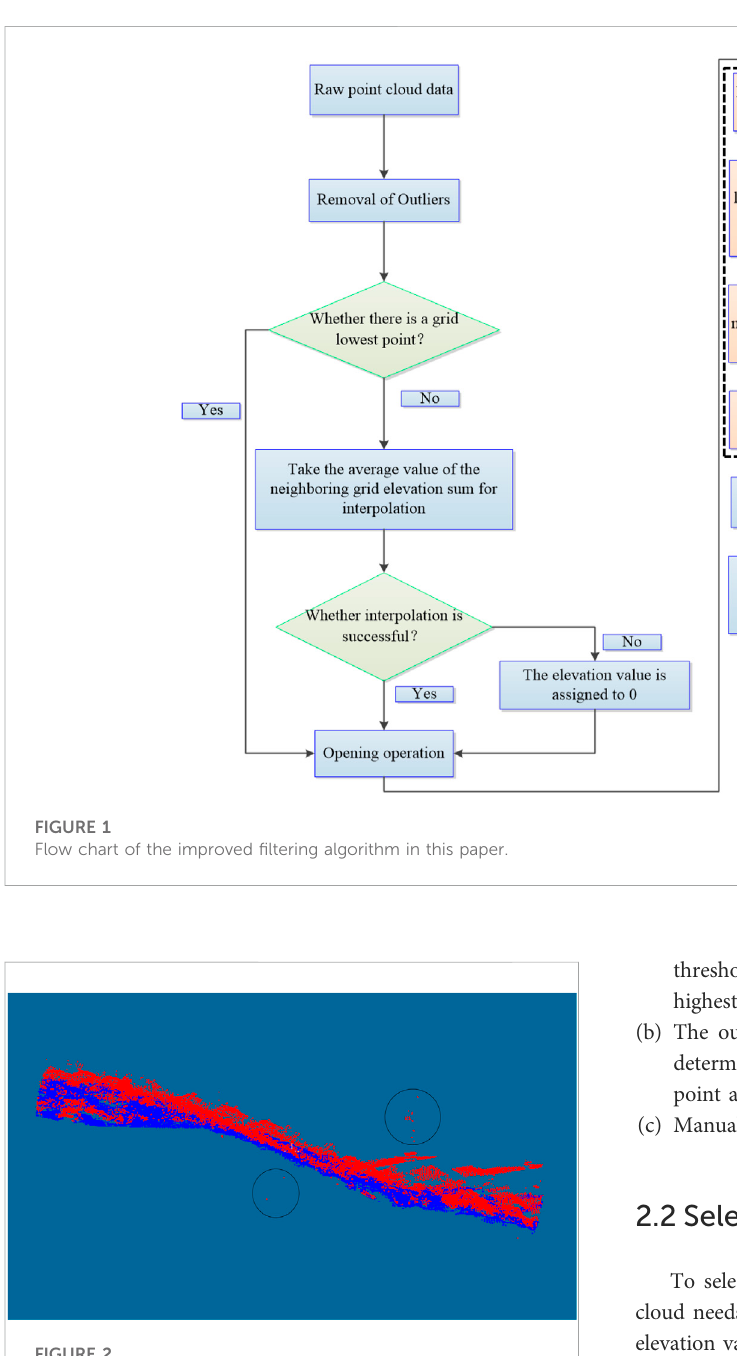
FIGURE 2 Outliers are present in